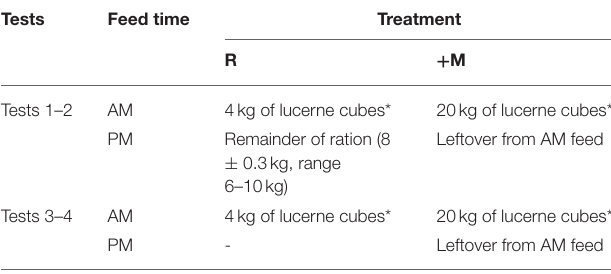
TABLE 1 | The feed ration schedule for cows in the restricted (R) and above maintenance ( + M) treatment groups per day for tests